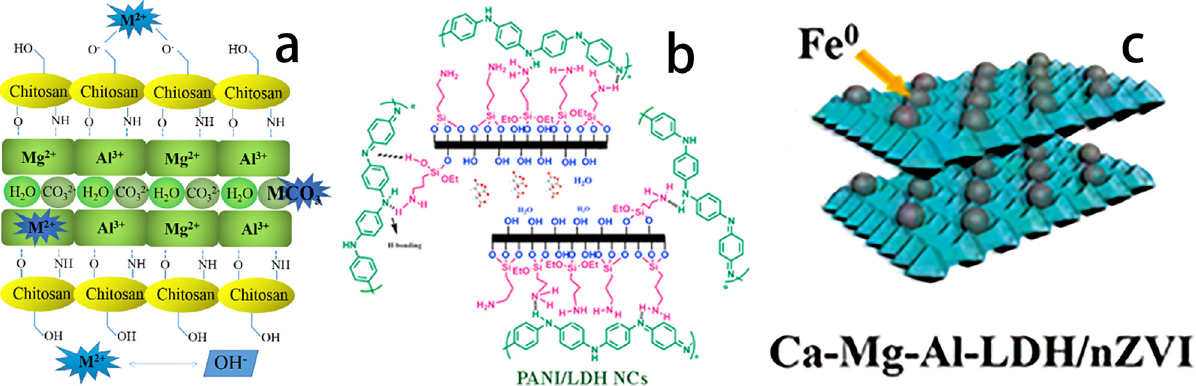
Figure 6: The structure diagrams of the LDH - based composite material: ( a ) direct cross - linking [ 80 ] ; ( b ) indirect cross - linking [ 81 ] ; and ( c ) in situ growth method [ 82 ]